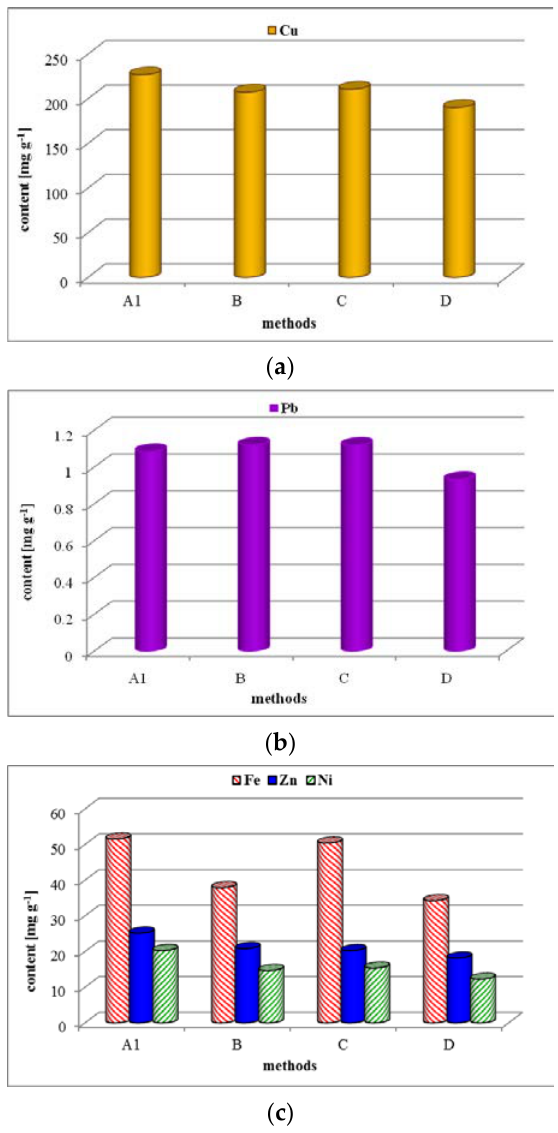
Figure 4. Content of Cu ( a ), Pb ( b ), Fe, Zn and Ni ( c ) in post-digestion solutions obtained by application of the US EPA 3052 Method (A1) and its modifications in the number of digestion steps (B, C) and amount of reagents